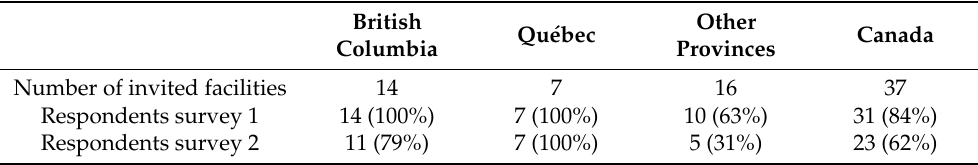
Table 2. Respondents to the first and second survey, by province or region.